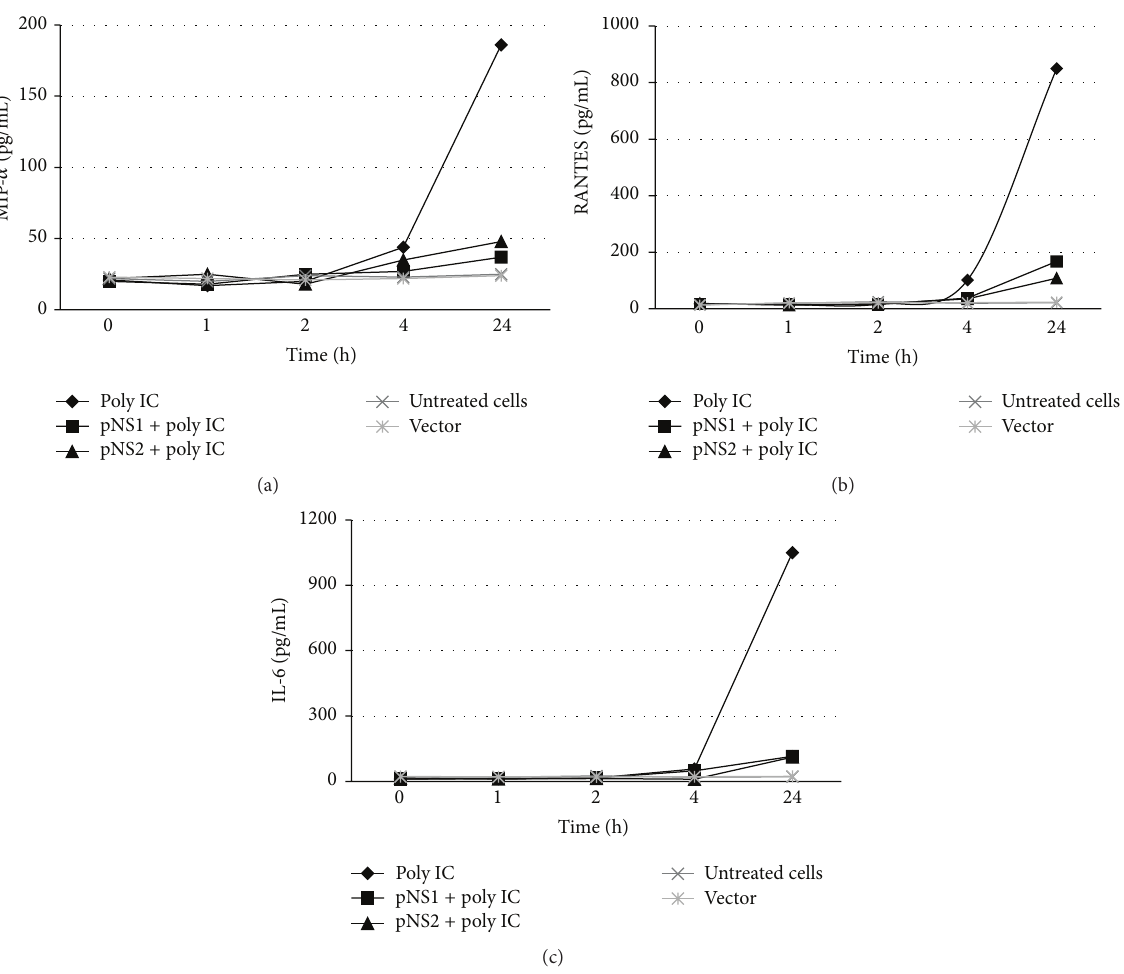
Figure 5: Chemokine expression in pNS1 or pNS2 transfected cells. A549 cells were transfected with pNS1 or pNS2 for 1h and then treated with poly IC at a final concentration of 10 𝜇 g/mL for the indicated times. The cultured supernatants were collected for determining the levels of MIP- 𝛼 (a), RANTES (b), and IL-6 (c) using ELISA. The results are shown as the mean ± SE of three independent